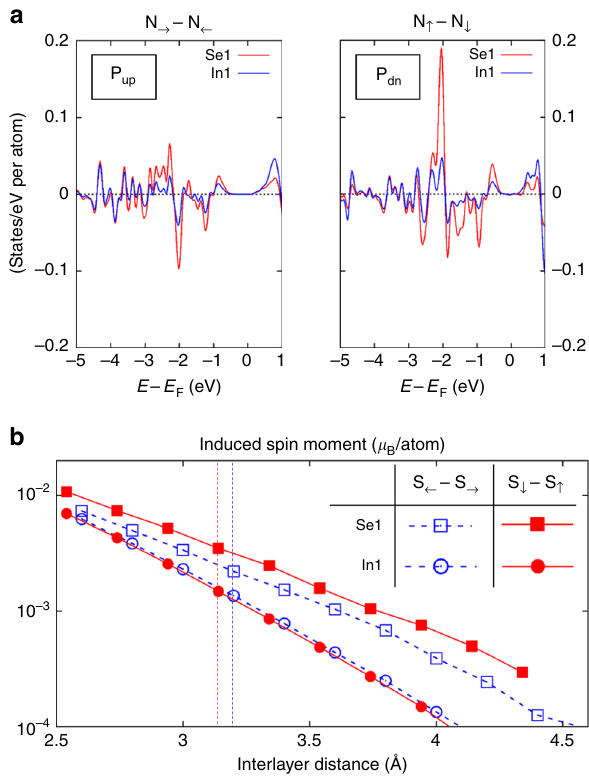
Fig. 4 Magnetoelectric effect in In 2 Se 3 , mediated by the magnetic proximity to Cr 2 Ge 2 Te 6 . a Projected spin density of states for the surface (Se1) and subsurface (In1) atomic layers close to Cr 2 Ge 2 Te 6 . Left and right panels correspond to the heterostructures with P up and P dn In 2 Se 3 , respectively, with the in-plane and out-of-plane spin quantization axis. Given the prohibited long-range magnetic order for the easy-plane 2D magnetic system, the spin-polarized In 2 Se 3 as shown by the left panel of ( a ) is only a ground state at zero Kelvin. But the easy-axis spin-polarized In 2 Se 3 as shown by the right panel of ( a ) is practical at fi nite temperatures. Hence, the magnetization of the semiconducting In 2 Se 3 can be switched by its own electric polarization, while in proximity to Cr 2 Ge 2 Te 6 . b Interlayer distance dependence of the proximity-induced Se1 and In1 spin moments. The vertical dashed lines denote the equilibrium distances predicted by PBE with D2 vdW correction. Note that the induced spin moments are negative, which means the interlayer antiferromagnetic proximity effect in the studied In 2 Se 3 -Cr 2 Ge 2 Te